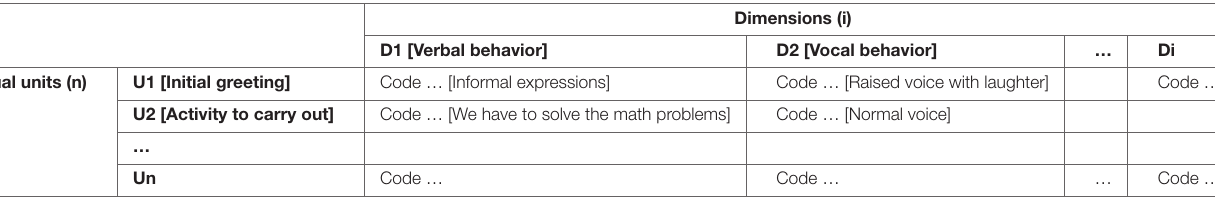
TABLE 2 | Tabular structure for creating a code